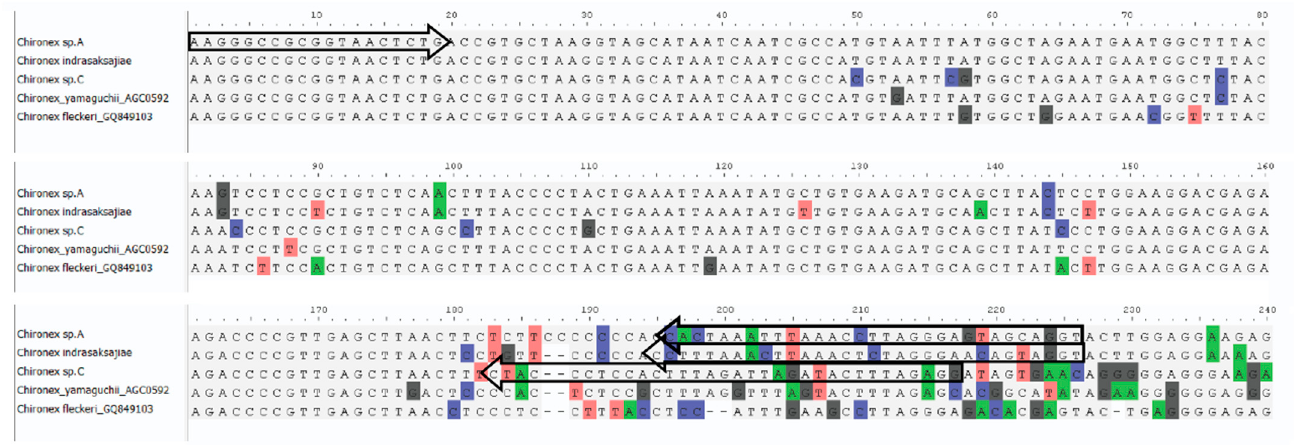
Figure 4. 16S rRNA sequence alignment from five Chironex species. The forward arrows are forward primers; the reverse arrows are reverse primers.